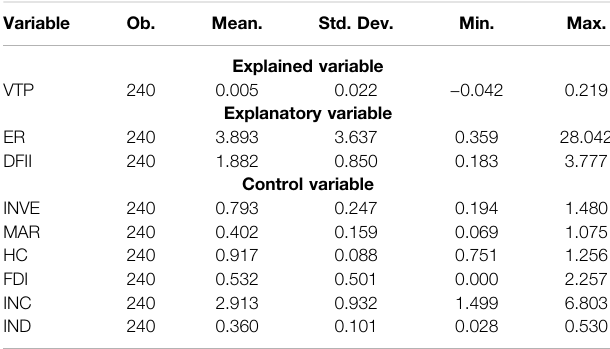
TABLE 3 | Variables